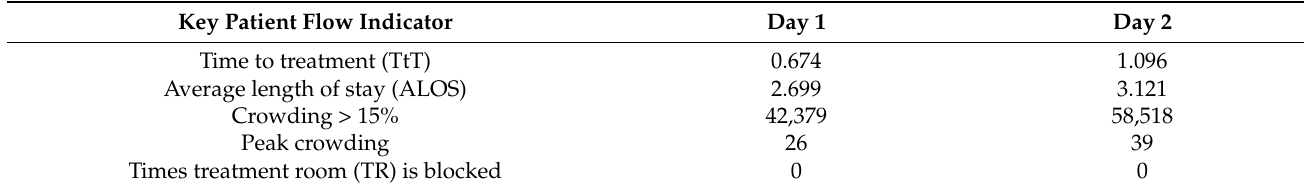
Table 5. Table displaying a subset selection of KPI from the Sc.1 output.